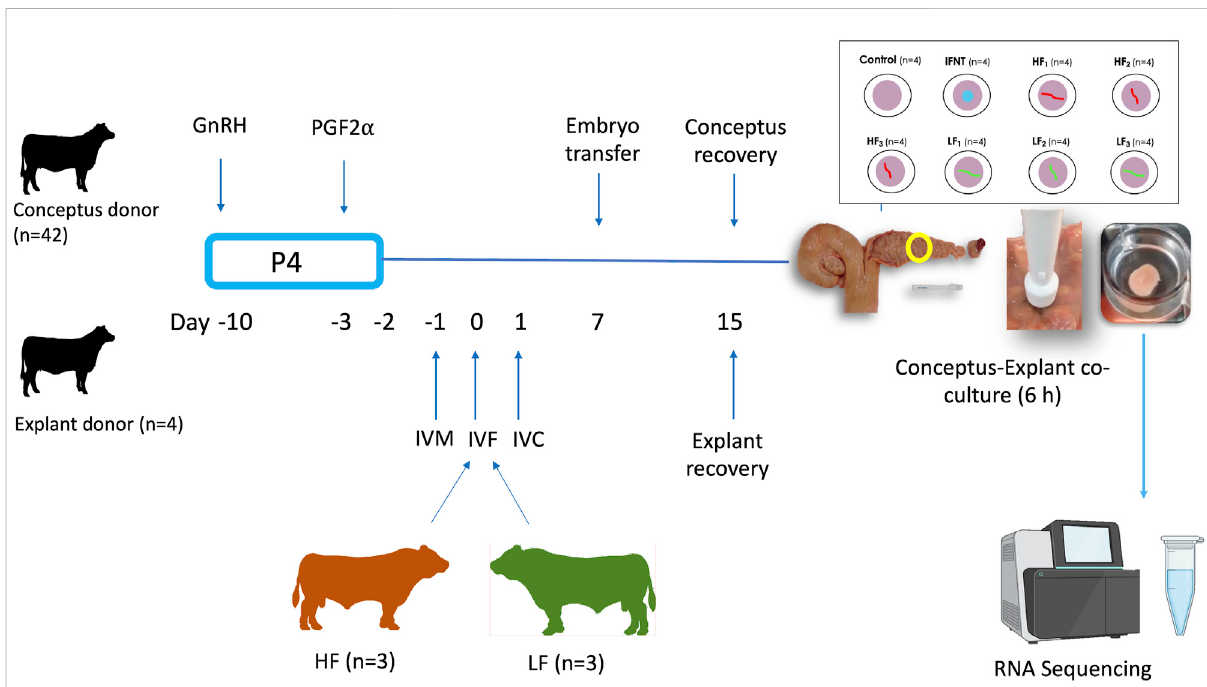
FIGURE 1 Experimental design. Estrous cycles of conceptus and explant donors were synchronized using an 8-days progesterone (P4) releasing device with GnRH at PRID insertion and prostaglandin 2 α the day before device removal. In parallel, oocytes recovered from slaughterhouse ovaries were matured in vitro (IVM), fertilised (IVF) with semen from these 6 bulls and cultured in vitro (IVC) to generate blastocysts for transfer. The day of IVF was the equivalent to the day of ovulation in the heifers. Day 7 blastocysts from each high fertility (HF) and low fertility (LF) bull were transferred in groups of 5 – 10 per bull into each conceptus donor, with 7 heifers allocated per bull, in order to generate elongated conceptuses. All heifers were slaughtered on Day 15. Following recovery, single conceptuses of similar length were co-incubated with endometrial explants for 6 h. Eight endometrialexplantswererecoveredfromeachofthe4explantdonors.Explantsfromeachexplantdonorwereexposedtomediumalone(Control; 4explants),100 ng/mlovinerecombinantinterferontau(IFNT;4explants),orasingleDay15conceptusfromeachoftheHFbulls(HF 1-3 ;12explants) and LF (LF 1-3 ; 12 explants) bulls. After the 6 h co-culture, explants were processed for RNA